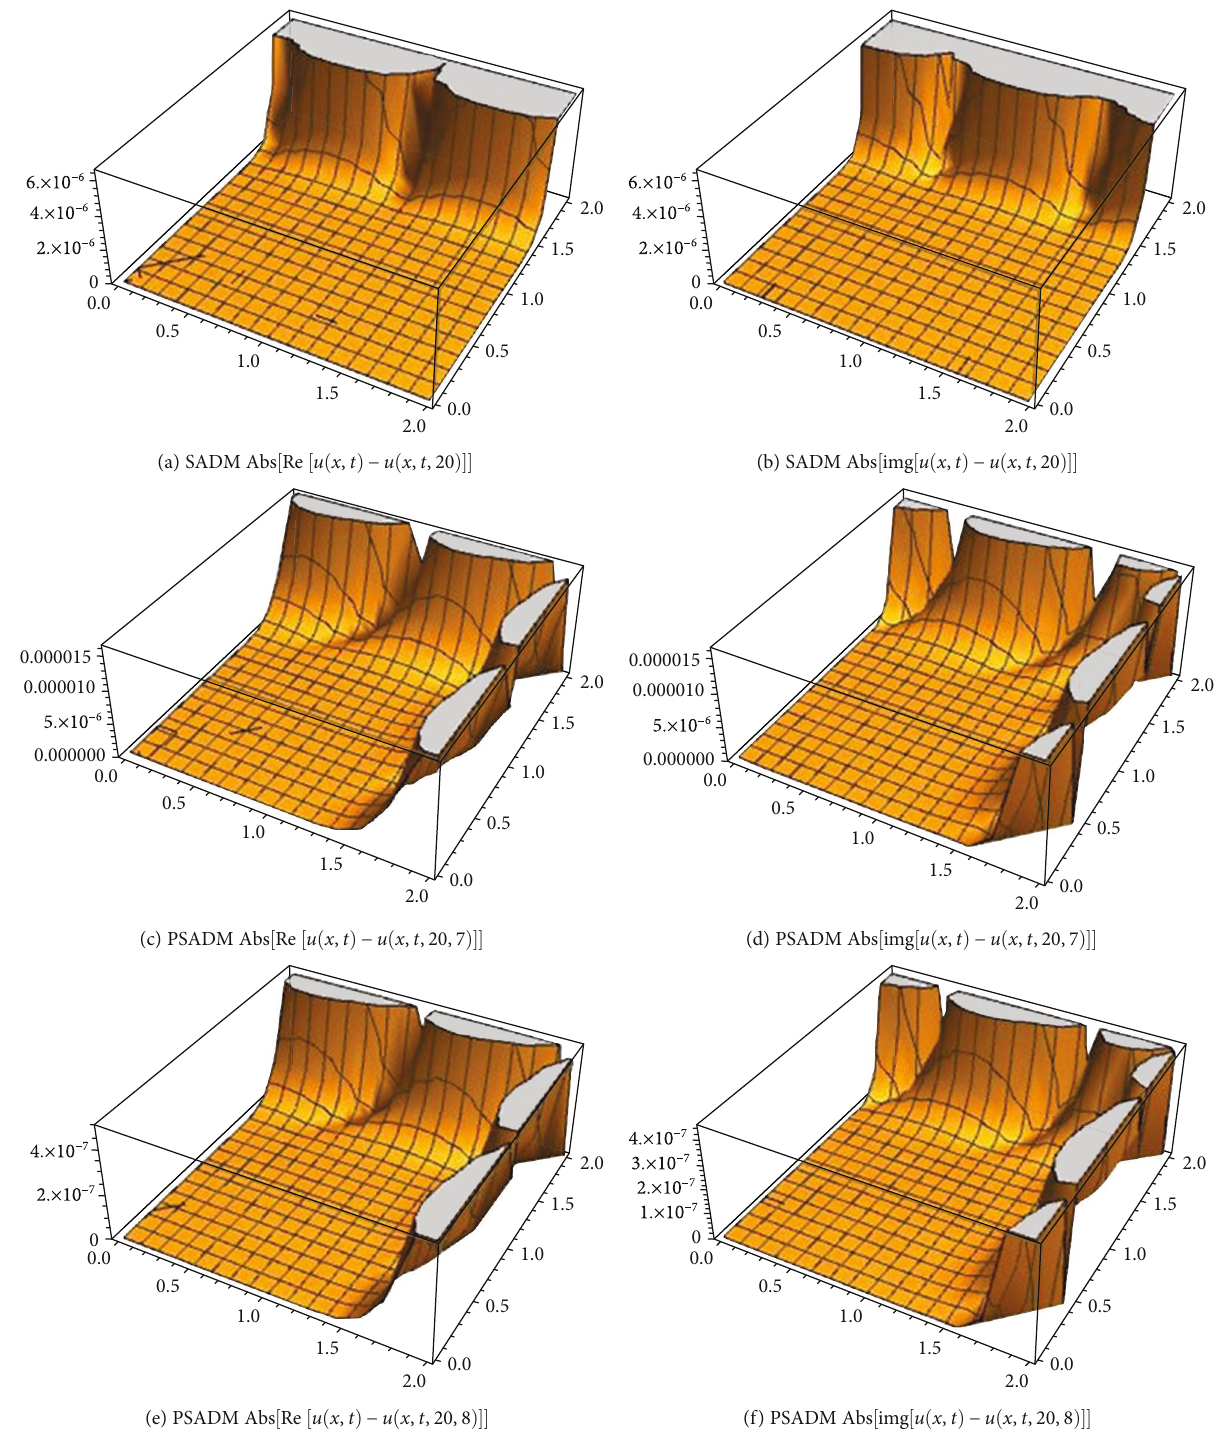
Figure 6: Absolute